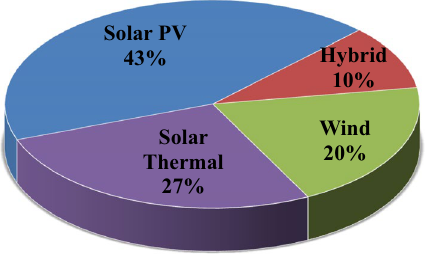
brane distillation, ED electrodialysis, PRO : pressure-retarded osmo- sis, VC vapor compression (He et al. 2015; Brauns 2010; Tufa et al. 2019; Tufa et al. 2015)